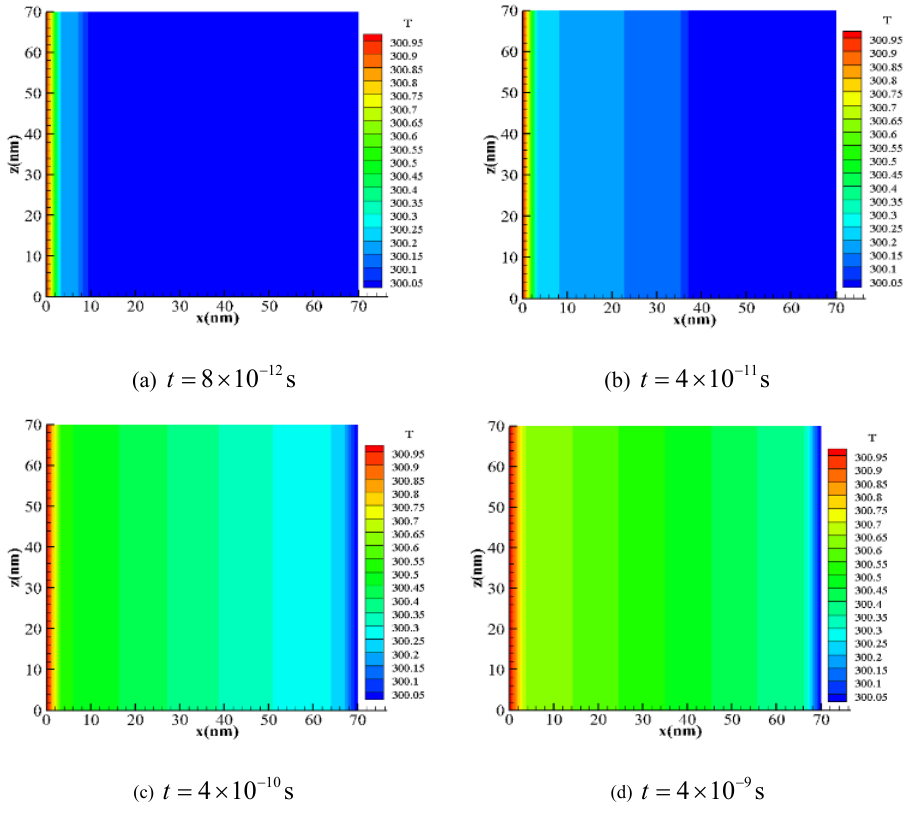
Fig. 3. Different t mirror boundary temperature jumps . Fig.3 displayed the dimensionless steady-state temperature distribution under the value of t with the size free path of the gas molecules along the middle line in the model, the boundary was under mirror rebound boundary. It can be seen from the Fig.4 that the boundary temperature jump was mainly concentrated on high temperature area of the left side, the right side still stay constant because there is no jump when time was less than 8 * 10 -12 . When the value of t was in 8 * 10 -12 ~ 4 * 10 -9 , it was obvious for the center area of the system to jump from the high temperature area to the lower, but it was not well- distributed that the left area of high temperature was relatively regular. When the value of t was the time t=4 * 10 -9 , it is relatively regular near high temperature area because the the ratio of the mean free path was equal to which the gas molecules to the characteristic